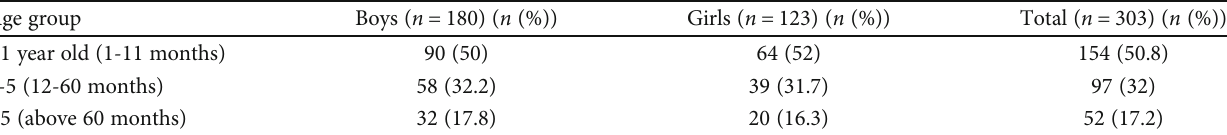
Table 1: Distribution of children with LRTI according to age and gender ( n = 303 ).